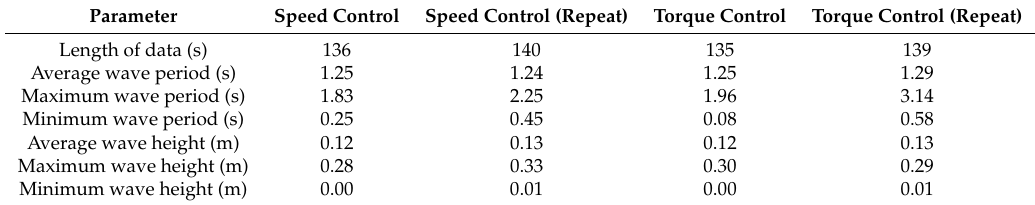
Figure 4. Surface elevation of one of the Regular wave-tow cases, demonstrating an average wave height of 0.19 m ( a , b ) the frequency spectrum of the signal. Table 4. Characteristics of the irregular wave tests using the zero up -crossing